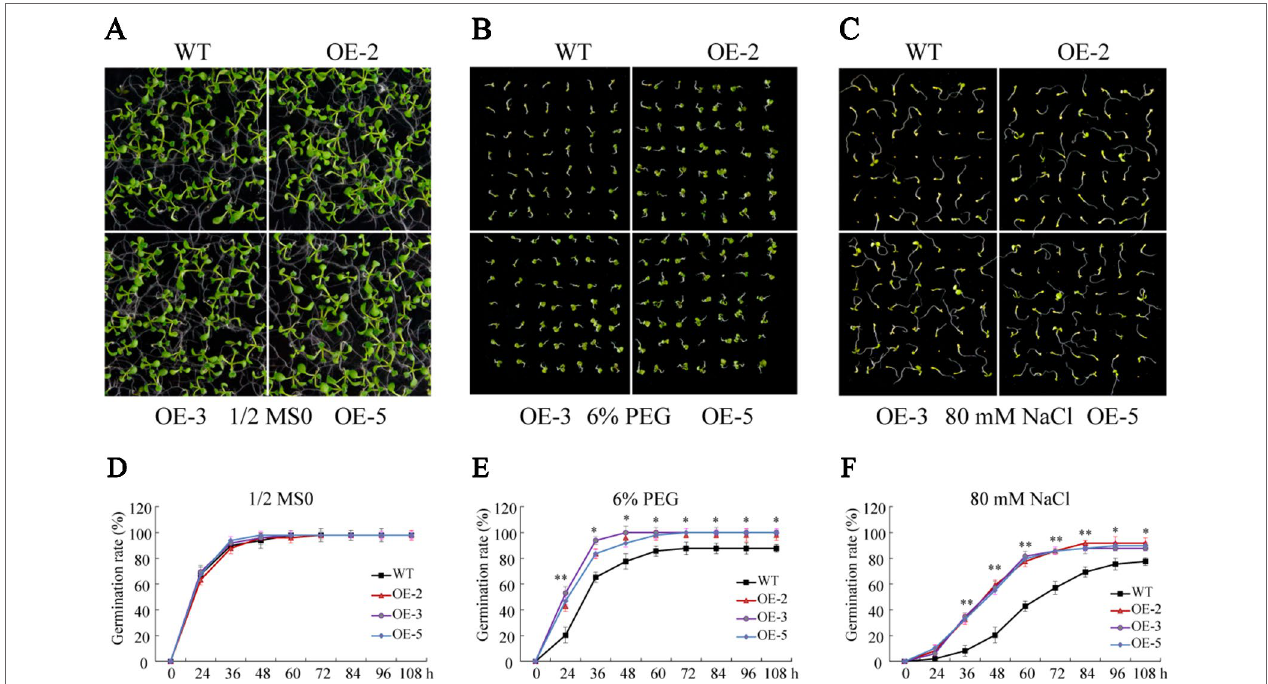
FiGURe 9 | Germination assays of wild-type (WT) and GmSAP16 transgenic Arabidopsis seeds under polyethylene glycol (PEG) and NaCl treatments. Phenotypes of WT and GmSAP16 transgenic Arabidopsis seeds on 1/2 Murashige and Skoog (MS) medium (A) , 1/2 MS medium containing 6% PEG (B) , and 1/2 MS medium 80 mM NaCl (c) . Germination rates of WT and GmSAP16 seeds on 1/2 MS medium (D) , 1/2 MS medium containing 6% PEG (e) , and 1/2 MS medium 80 mM NaCl (F) . At least 80 seeds of each genotype were applied in the germination assays. Three biological replicates were performed, and error bars indicate ± SE of three replicates. Asterisks indicate statistical significance (*, P 0.05; and **, P 0.01; Student’s t test) compared with the corresponding